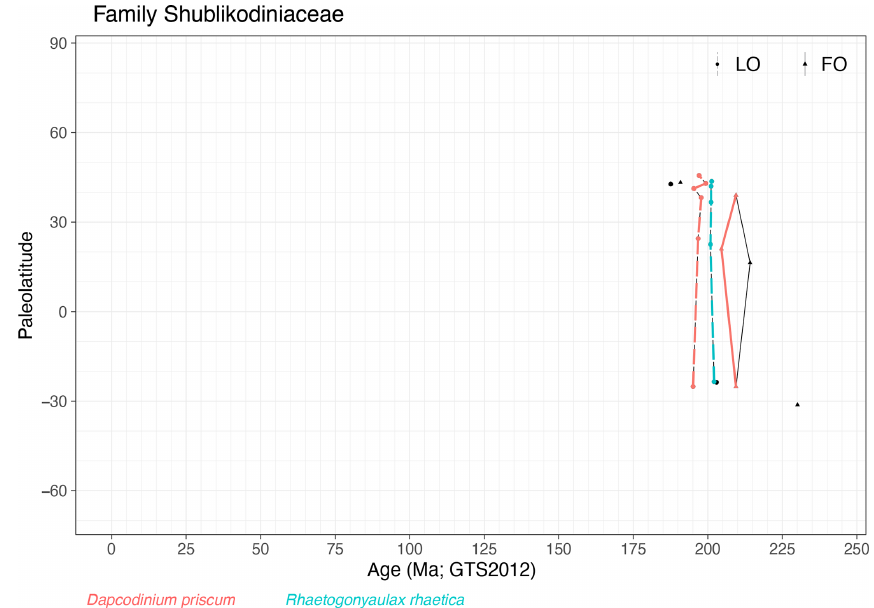
Figure 16. Same as Fig. 5 but for the family Shublikodiniaceae.